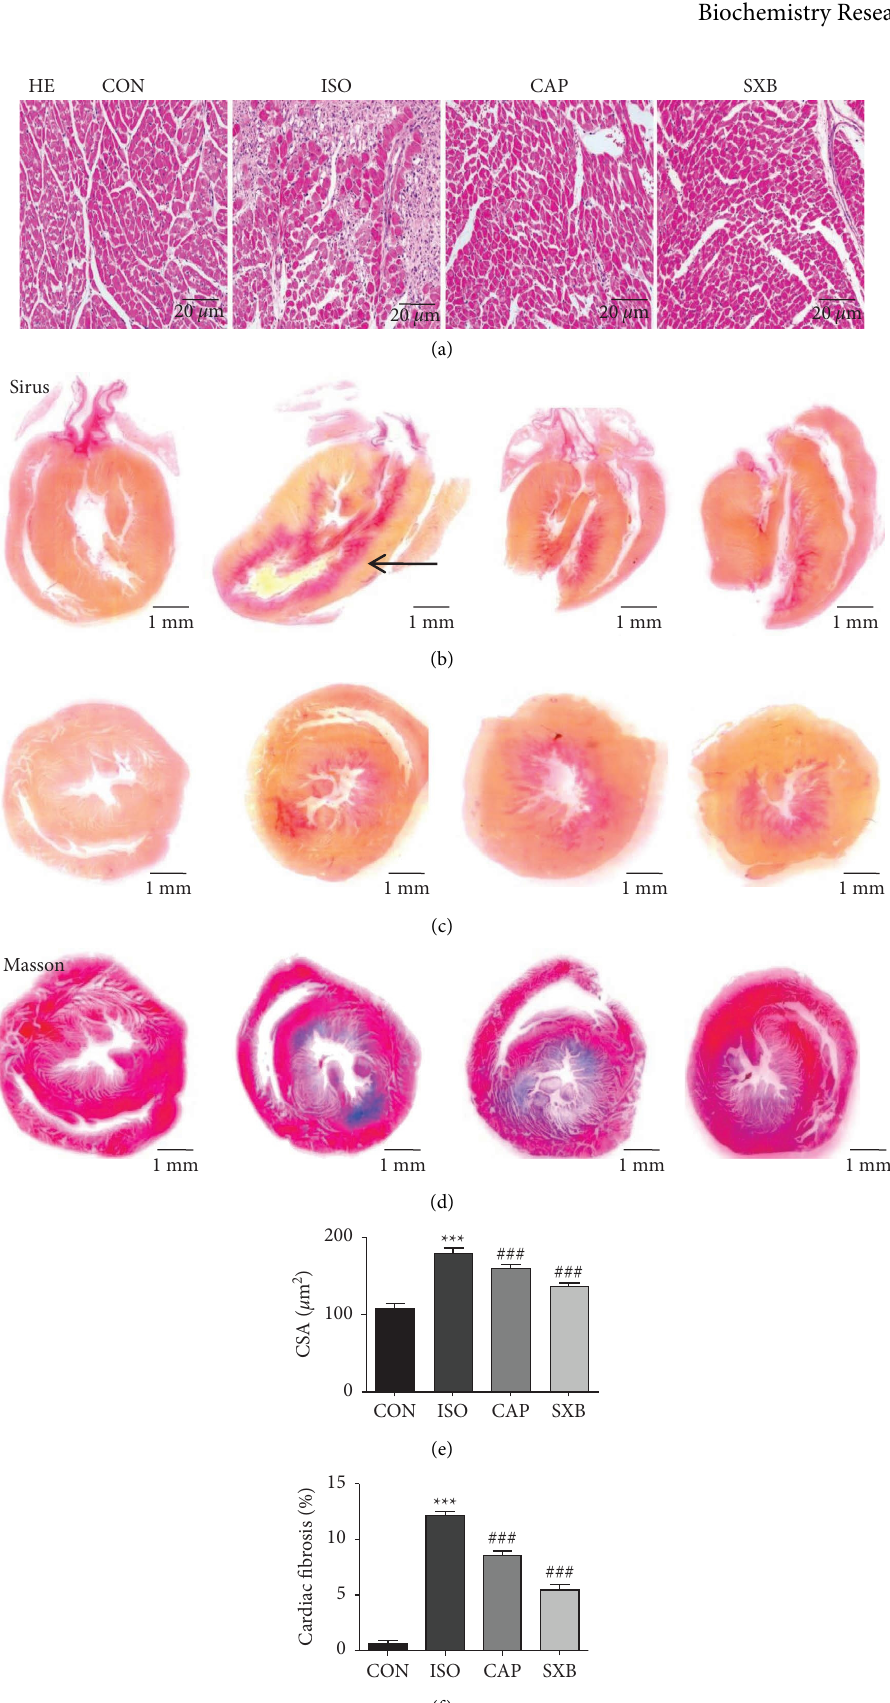
Figure 2: Pathological sections among the CON, ISO, CAP, and SXB groups. (a) HE-stained, (b) long-axis Sirius red-stained, (c) short-axis Sirius red-stained, and (d) Masson-stained heart sections among the CON ( n � 13), ISO ( n � 13), CAP ( n � 7), and SXB groups ( n � 9). (e) Mean CSA of cardiomyocytes and (f) the fraction of fbrotic area. ∗∗∗ P < 0 . 001, vs. the CON group. ### P < 0 . 001, vs. the ISO